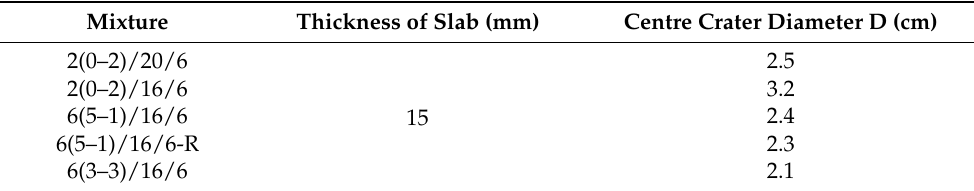
Table 8. Average crater diameter for 15 mm thickness slabs for each mixture.